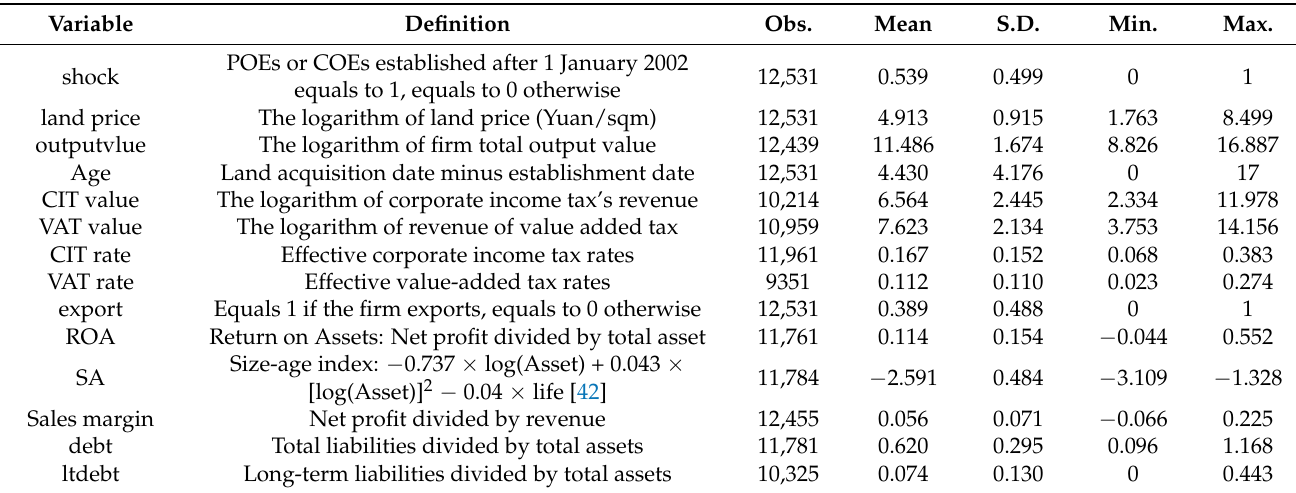
Table 1. Variable definition and summary